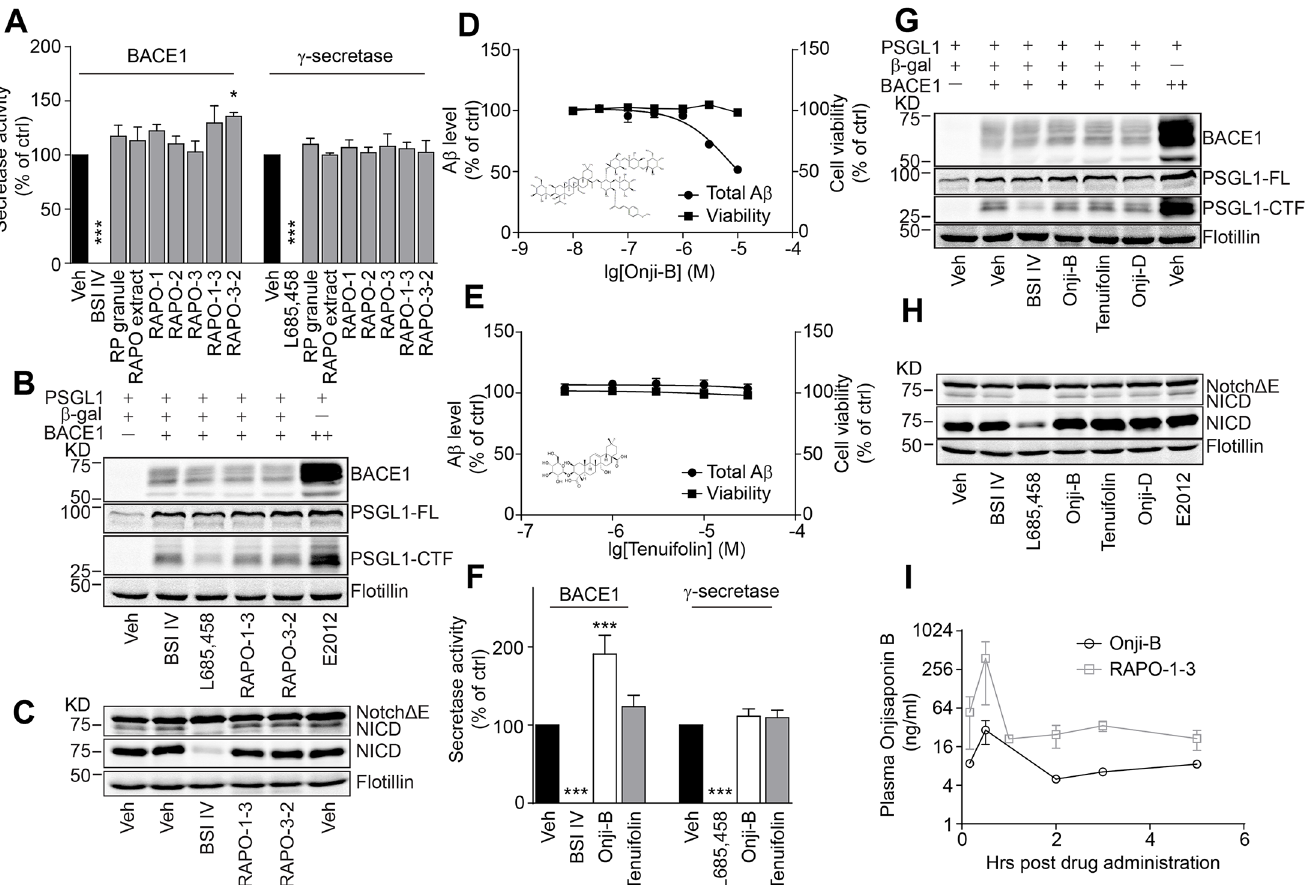
Fig 2. RAPO-1-3 and Onjisaponin B reduce A β generation without affecting the enzymatic activity of BACE1 or γ -secretase. (A) RAPO fractions (1 mg/ml) do not alter the activity of BACE1 or γ -secretase. (B-C) Neither RAPO-1-3 nor RAPO-3-2 (1 mg/ml) changes the processing of PSGL1 by BACE1 (B) or of Notch by γ -secretase (C). Onjisaponin B (D) but not Tenuifolin (E) reduces A β production without inhibiting BACE1 or γ -secretase (F) activity. (G-H) Neither Onjisaponin B nor Tenuifolin (10 μ M) alters the processing of PSGL1 by BACE1 (G) or of Notch by γ -secretase (H). (I) Onjisaponin B concentration within mouse plasma after the acute administration of RAPO-1-3 or Onjisaponin B. In the figures, Onji-B stands for Onjisaponin B. Data are presented as the mean ± s.e.m. * p < 0.05, ** p < 0.01 and *** p < 0.001. One-way ANOVA with Bonferroni's multiple comparison test (A,